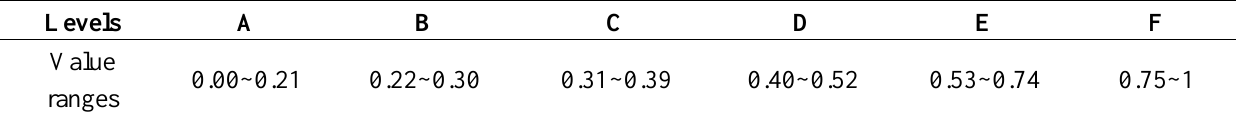
Table 4. The level of transit service classification.